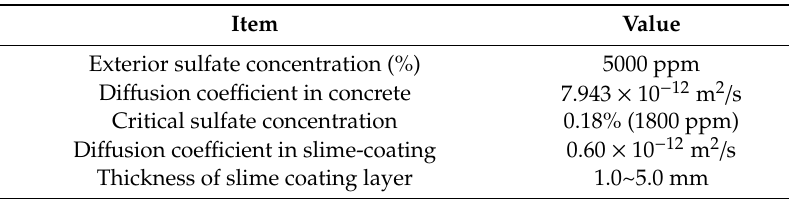
Table 3. Analysis conditions for sulfate di ff usion.